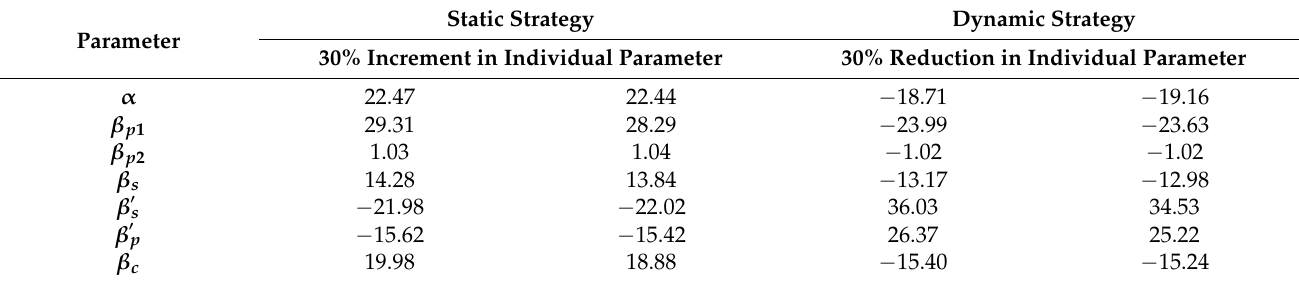
Figure 9. Results generated by the dynamic strategy in five cases. ( a ) Forecasted number of infections; ( b ) optimal trajectory of the strength of the pandemic prevention and control generated by PMP; ( c ) optimal trajectory of the strength of the economic stimulation generated by PMP; ( d ) optimal level of socio-economic activity generated by PMP; ( e ) total socio-economic benefit generated by PMP. Table 3. Percentage change in total socio-economic benefit when the individual parameter is changed by